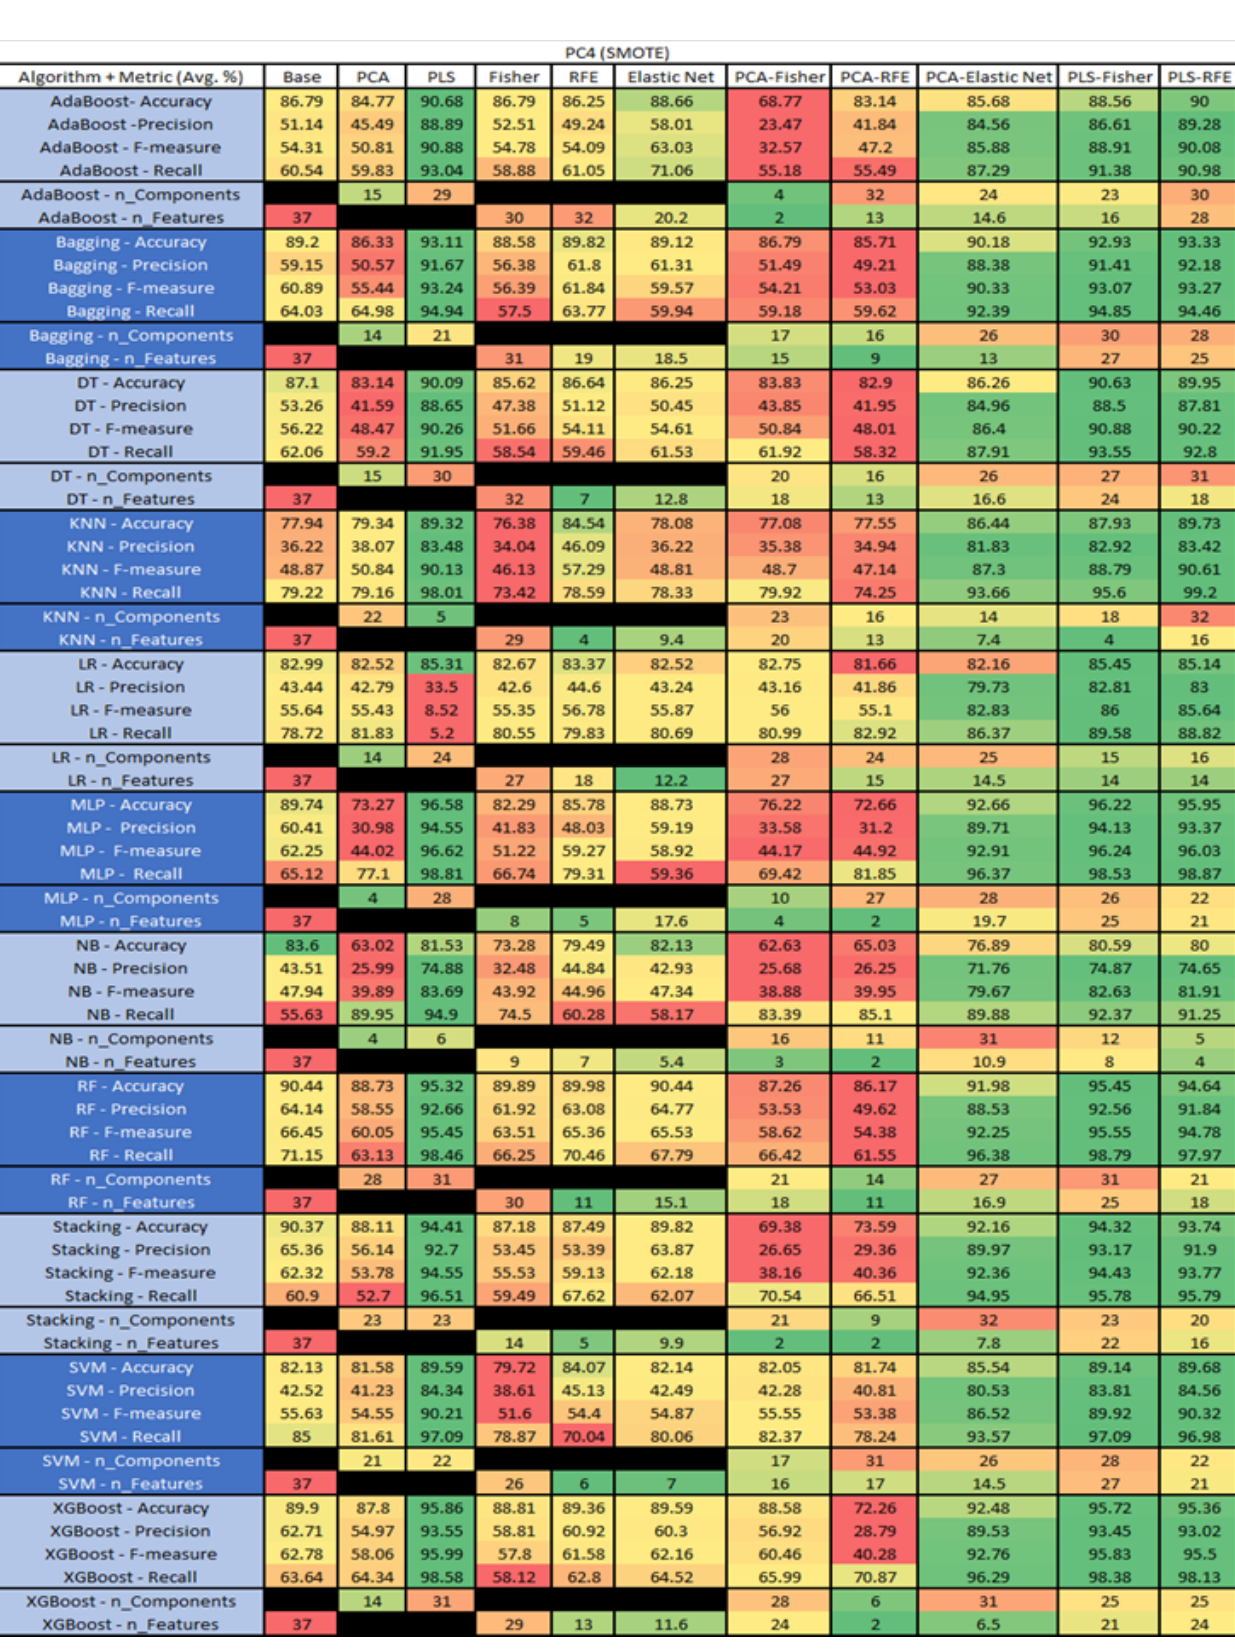
Figure 47. PC4 SMOTE NASA MDP Results Data